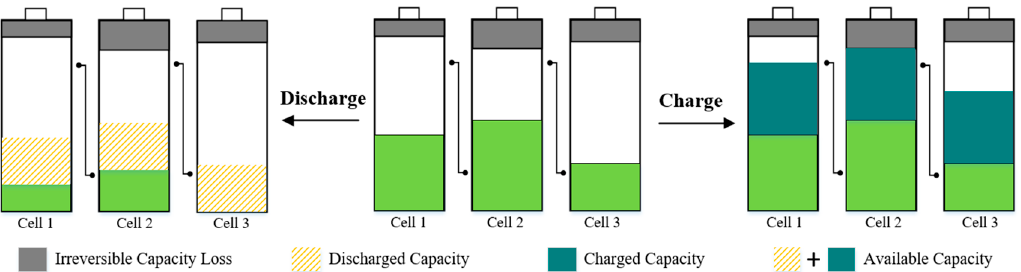
Figure 1. Charge and discharge of unbalanced battery string. Battery equalizers are widely used in multi ‐ battery systems to maintain balanced charge among cells [6]. Equalization topologies can be categorized into passive and active methods by the management of surplus energy [7]. The passive methods transform energy from cell to heat by shunting resistor. Fixed shunting resistor equalizer is the sim ‐ plest method to implement due to its unnecessary control [8]. Switch shunting resistor equalizer connected or disconnect with cells by switches and therefore is more efficient than fixed shunting resistor equalizer [7]. Analog shunting resistor equalizer controls the resistors’ connection status by voltage reference [9]. It has the advantage of un ‐ necessary control but requires a relatively higher cost. The passive method is widely employed in the EV industry because of its low ‐ cost,